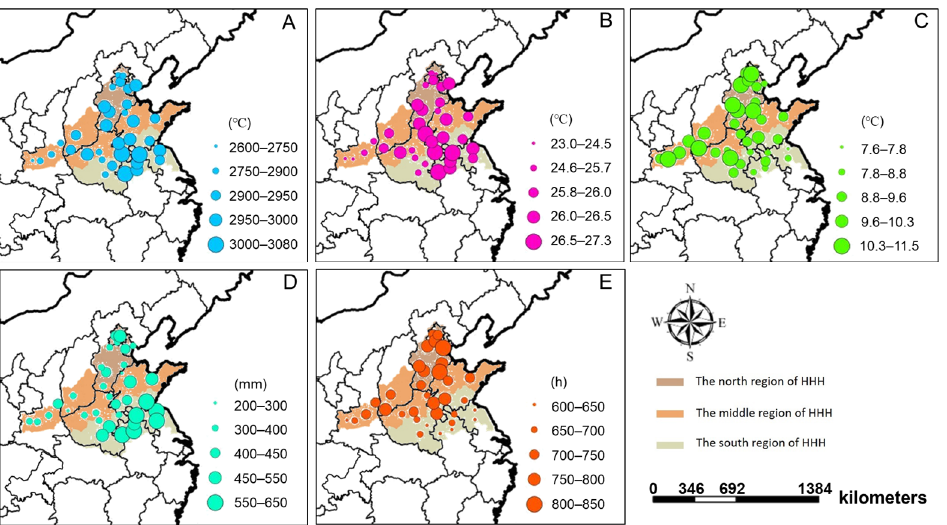
Figure 3. Spatial distributions of temperature accumulation (≥10 °C, A ), average temperature ( B ), diurnal temperature range ( C ), total precipitation ( D ), and sunshine hours ( E ) from sowing to maturity during the study years.